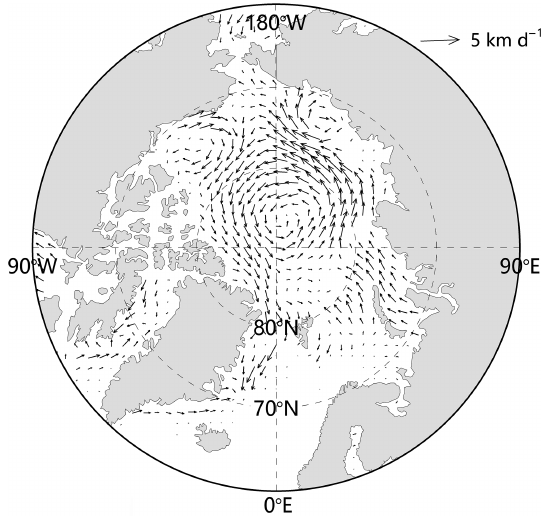
Figure 11. Anomalies of the spring (April to June) SIM in 2020 relative to the climatology of the years